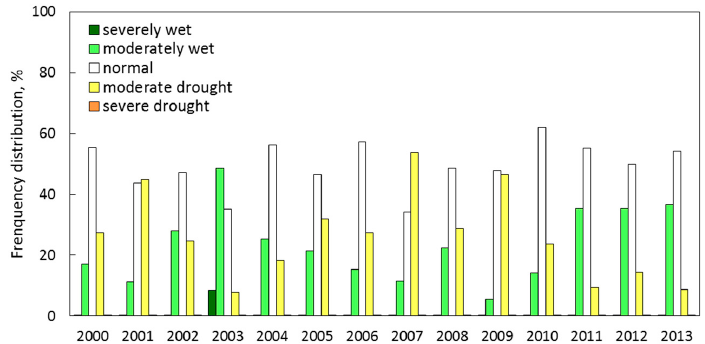
Figure 4. Frequency distribution of the MDSI anomaly with five categories of the total area during the growing season of 2000–2013: (i) severely wet: >2 (green bars); (ii) moderately wet: 0.5 to 1.99 (light green bars); (iii) normal: 0.49 to − 0.49 (white bars); (iv) moderate drought: − 0.5 to − 1.99 (light yellow bars); and (v) severe drought: < − 2 (orange bars).